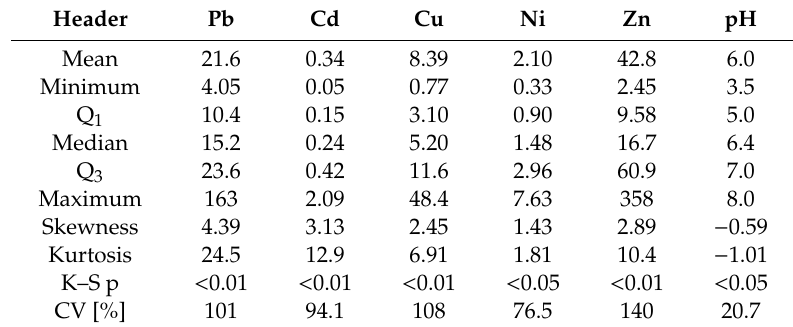
Figure 2. Spatial distribution of ( a ) pH and mobile fractions of: ( b ) Zn; ( c ) Cd; ( d ) Ni; ( e ) Cu; ( f ) Pb in soil. Table 1. Summary of descriptive statistics for metal contents (mg kg − 1 ) and pH in examined soil samples (n =